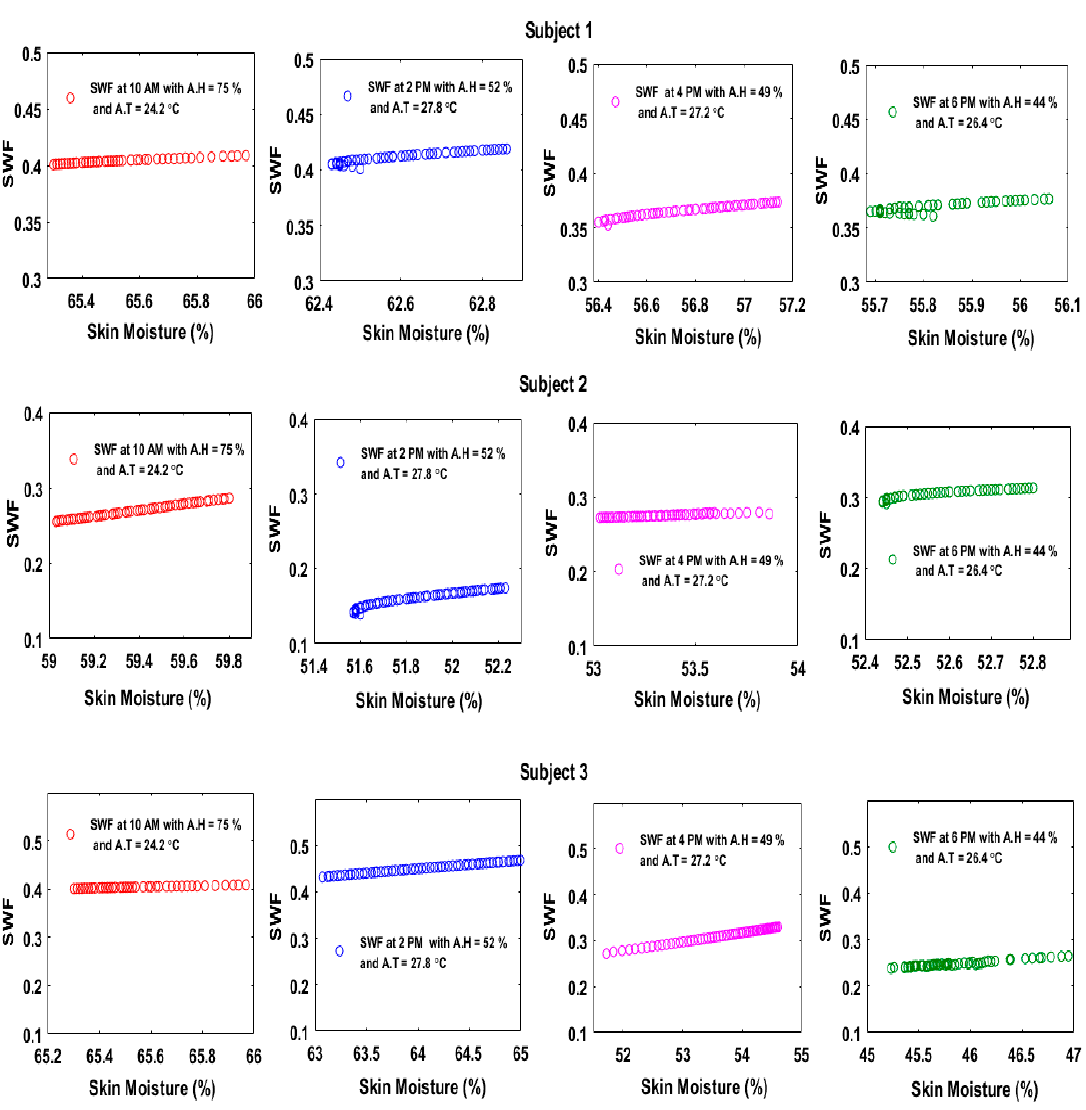
ff erent times of the day during the indoor Figure 11. SWF of three subjects at different times of the day during the indoor experiment. Figure 11. SWF of three subjects at di